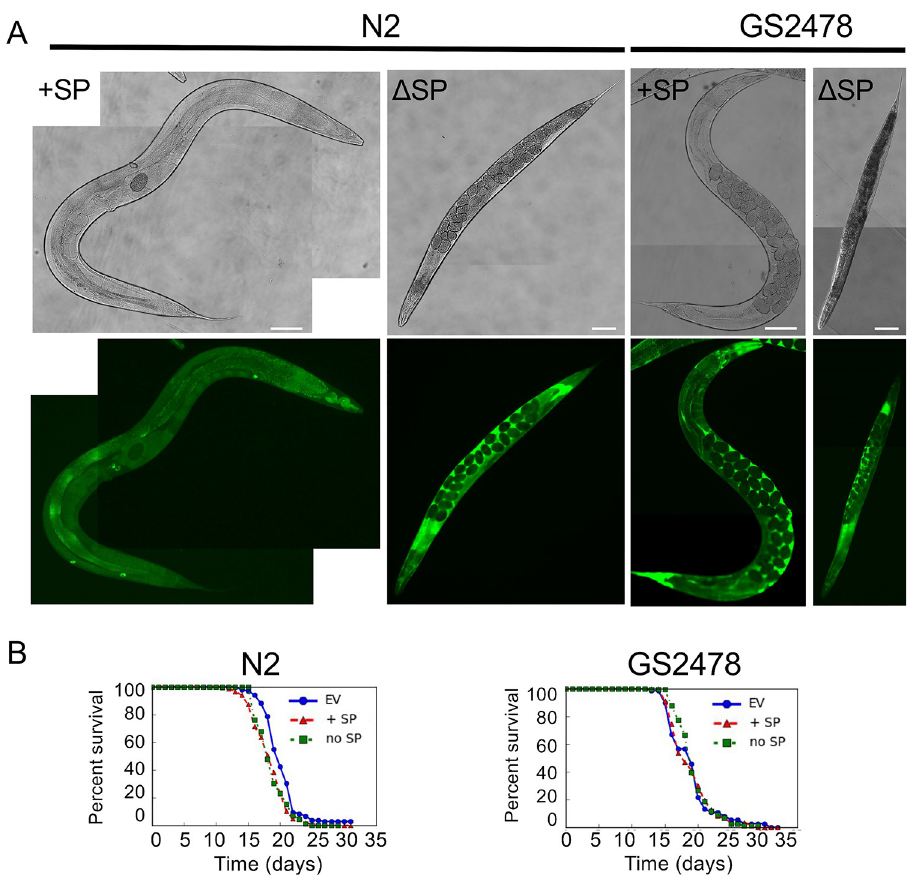
Fig 8. CyrA expression in the C . elegans hypodermis reduces the life span. (A) The cyrA gene fused to GFP was expressed with (strain KIT01) and without its signal peptide sequence (strain KIT23) in C . elegans N2 and GS2478 ( Δ cup-8, strains KIT31/KIT29) under the hypodermal and adult specific promoter of the col-19 gene . Scale bars = 100 μ m. (B) Survival curves of N2 and GS2478 expressing cyrA with (strain KIT22/KIT28) and without SP sequence (strain KIT18/KIT30). The empty vector (EV) was expressed in both strains as a control. Lifespan assays were performed on NGM plates with 150 mM FudR at 20˚C. P—values log-rank-test N2: EV v.s. no SP = 0.0001; EV v.s. +SP = 1.2E-06; P—values GS2478: EV v.s. no SP = 0.9; EV v.s. +SP =